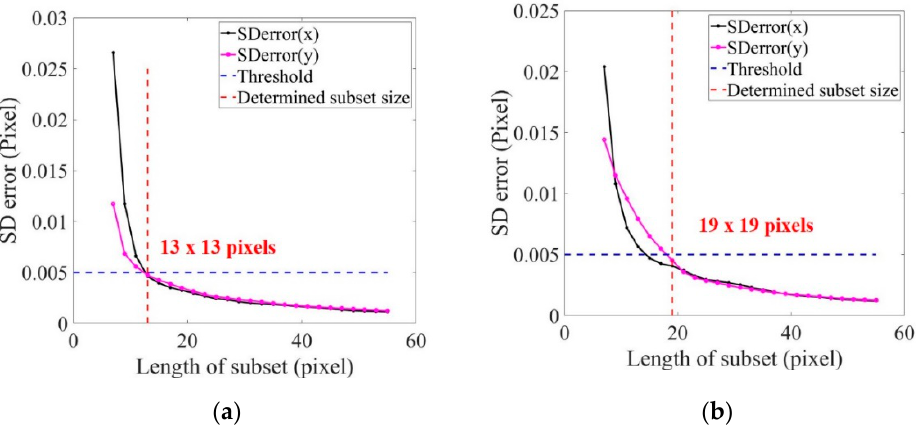
Figure 11. Randomly selected two seed points in the ROI of the fatigue crack specimen. From the randomly selected two different seed points, the subset sizes of 13 × 13 pixels and 19 × 19 pixels are respectively computed throughout the entire ROI when the threshold value of 0.005 is